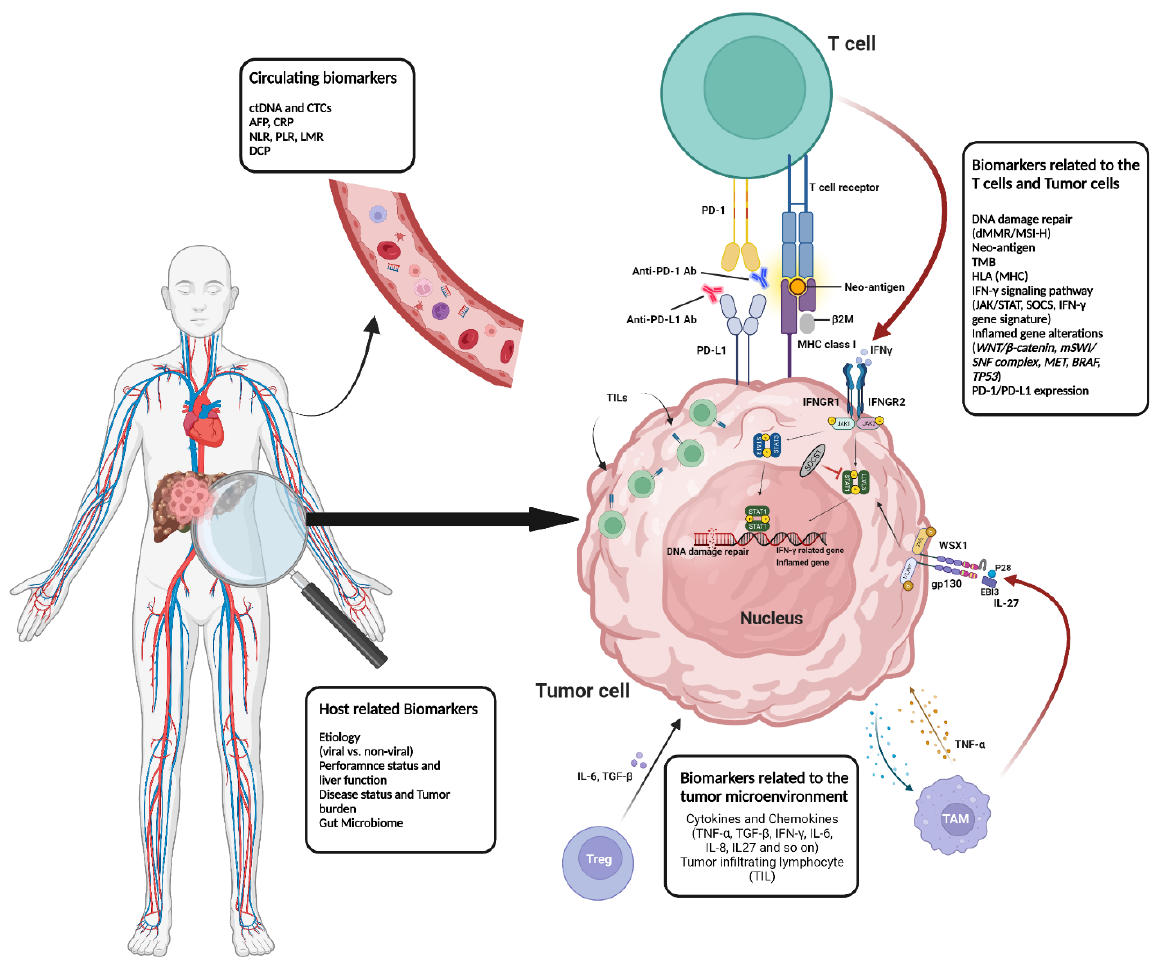
Figure 1. Schematic figure representing predictive biomarkers of immunotherapy in